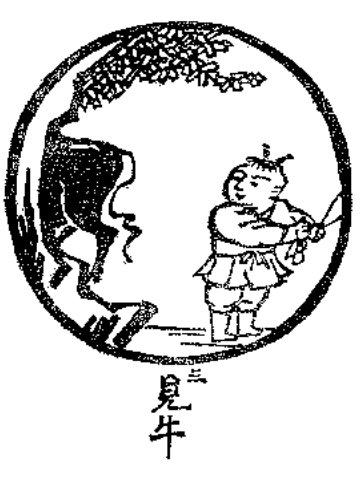
Figure 3. Perceiving the